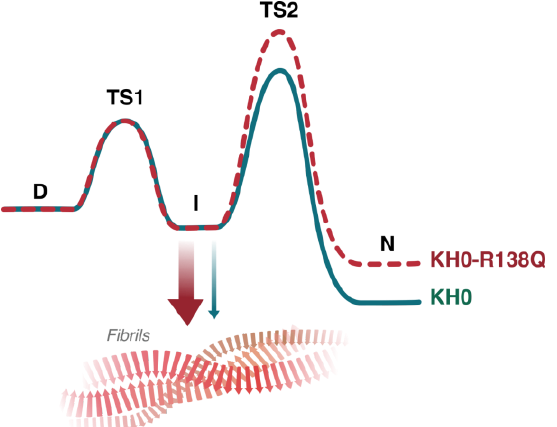
Figure 6. Proposed model for the enhanced aggregation propensity of KH0-R138Q mutant. In the case of KH0-R138Q mutant, a more populated intermediate state (I), due to a higher energy barrier between the I and N state (TS2), could facilitate KH0-R138Q reaching the fibrillar state. It cannot be excluded that the destabilization of the native state of KH0-R138Q with respect to KH0 (N) also plays a role in the fibrillogenesis process.